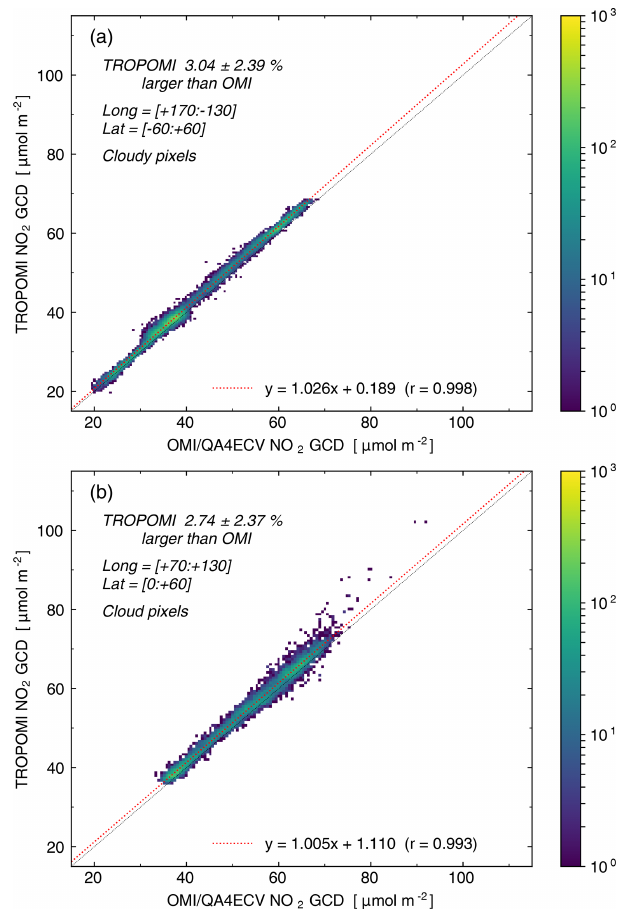
Figure 7. Same as Fig. 6 but for cloudy ground